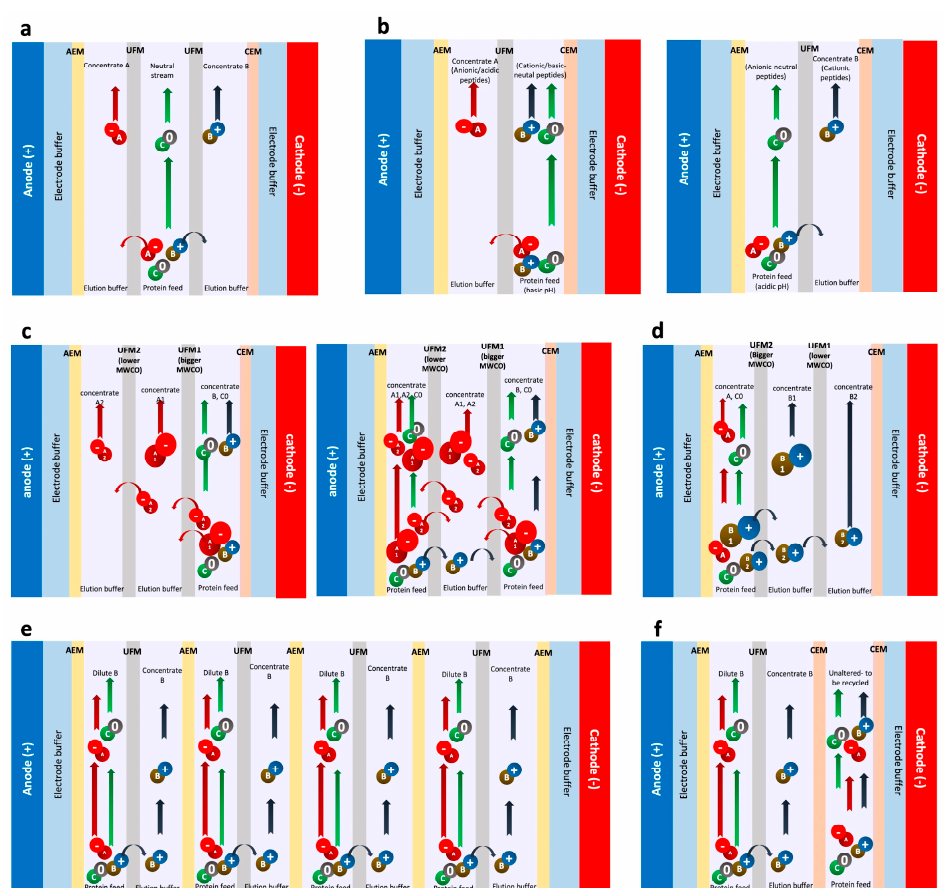
Figure 3. Electrodialysis with UF membrane (EDUF) with six different configurations for ( a ) parallel fractionation of cationic and anionic peptides (single feed); ( b ) cationic and anionic peptides fractionation at basic (left) and acidic pH of feeds (right), respectively (single feed); ( c ) series fractionation by double UFM for anionic peptides in different compartment with single feed (left) or for anionic peptides in single compartment with dual feeds (right); ( d ) series fractionation by double UFM for cationic peptides in different compartment (single feed); ( e ) alternating anion-exchange membrane and UFM for acidic peptides fractionation (multiple feeds); ( f ) double CEM for cationic peptides fractionation (double feeds). CEM: cation-exchange membrane; A or AEM: anion-exchange membrane; UFM: UF membrane.